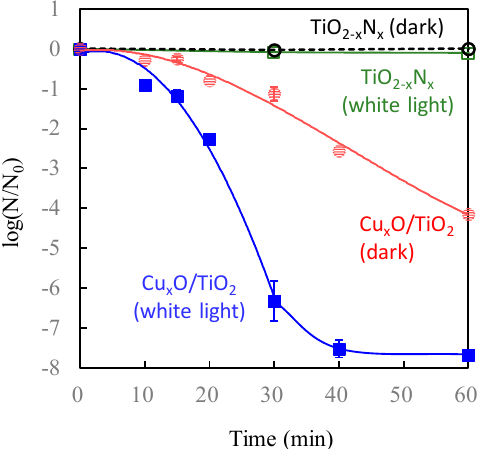
Figure 12. Inactivation of bacteriophage Q β for various samples. Cu x O / TiO 2 under white light (blue), Cu x O / TiO 2 under dark conditions (red), TiO 2-x N x under white light (green), and TiO 2-x N x under dark conditions (black) [33]. Light irradiation was conducted using a commercial 10 W cylindrical white fluorescent lightbulb with a UV cut-off film at an illuminance of 800 lux.